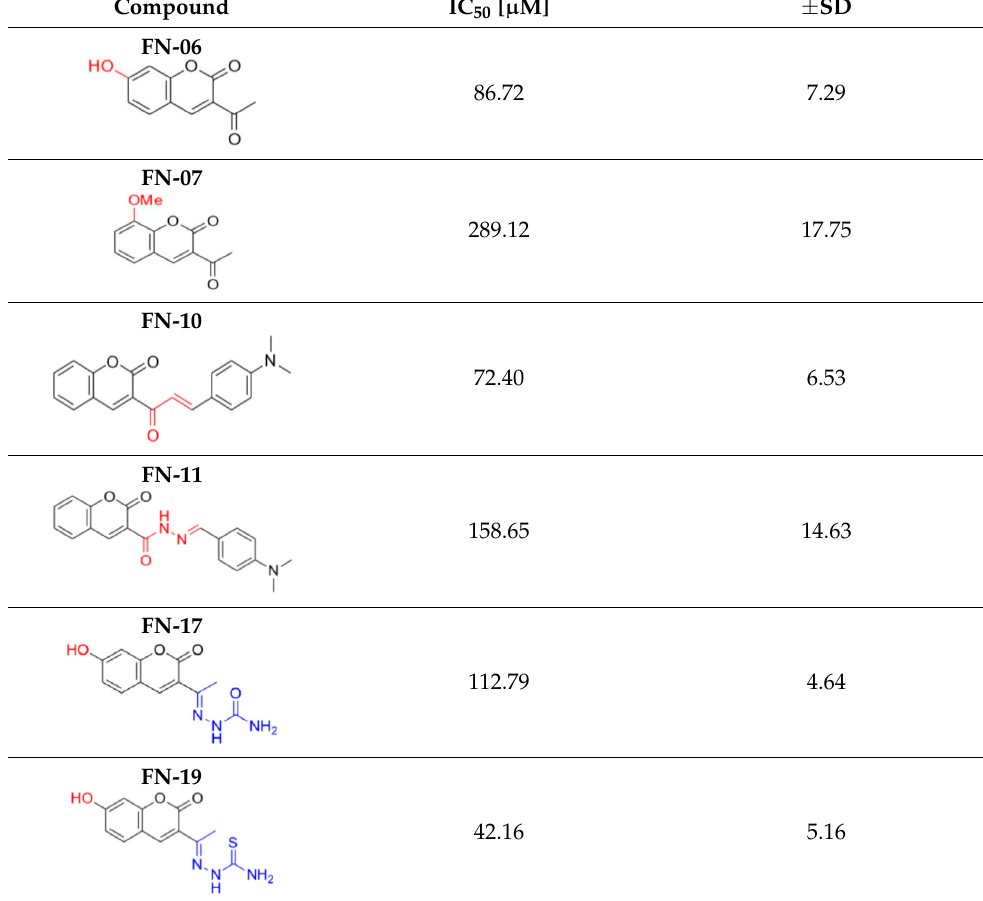
Table 1. Inhibitory activity of coumarin-based compounds on mushroom tyrosinase.